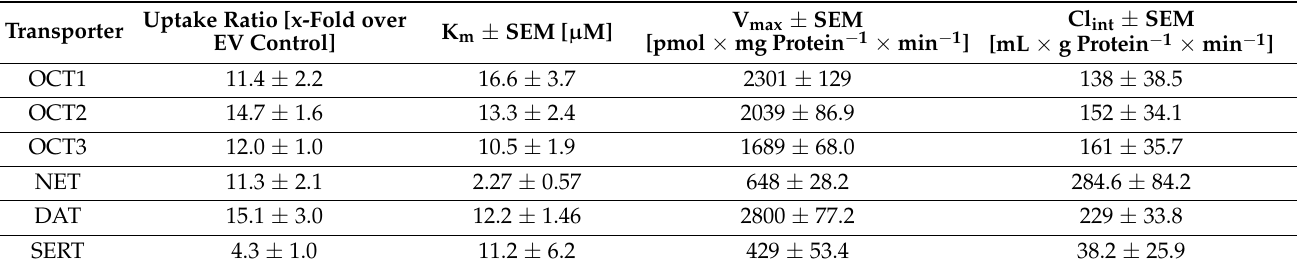
Figure 5. Concentration-dependent uptake of meta -iodobenzylguanidine by the investigated trans- porters. Transport is presented as net uptake with the mean ± SEM of three independent experiments. Table 1. Uptake characteristics of meta